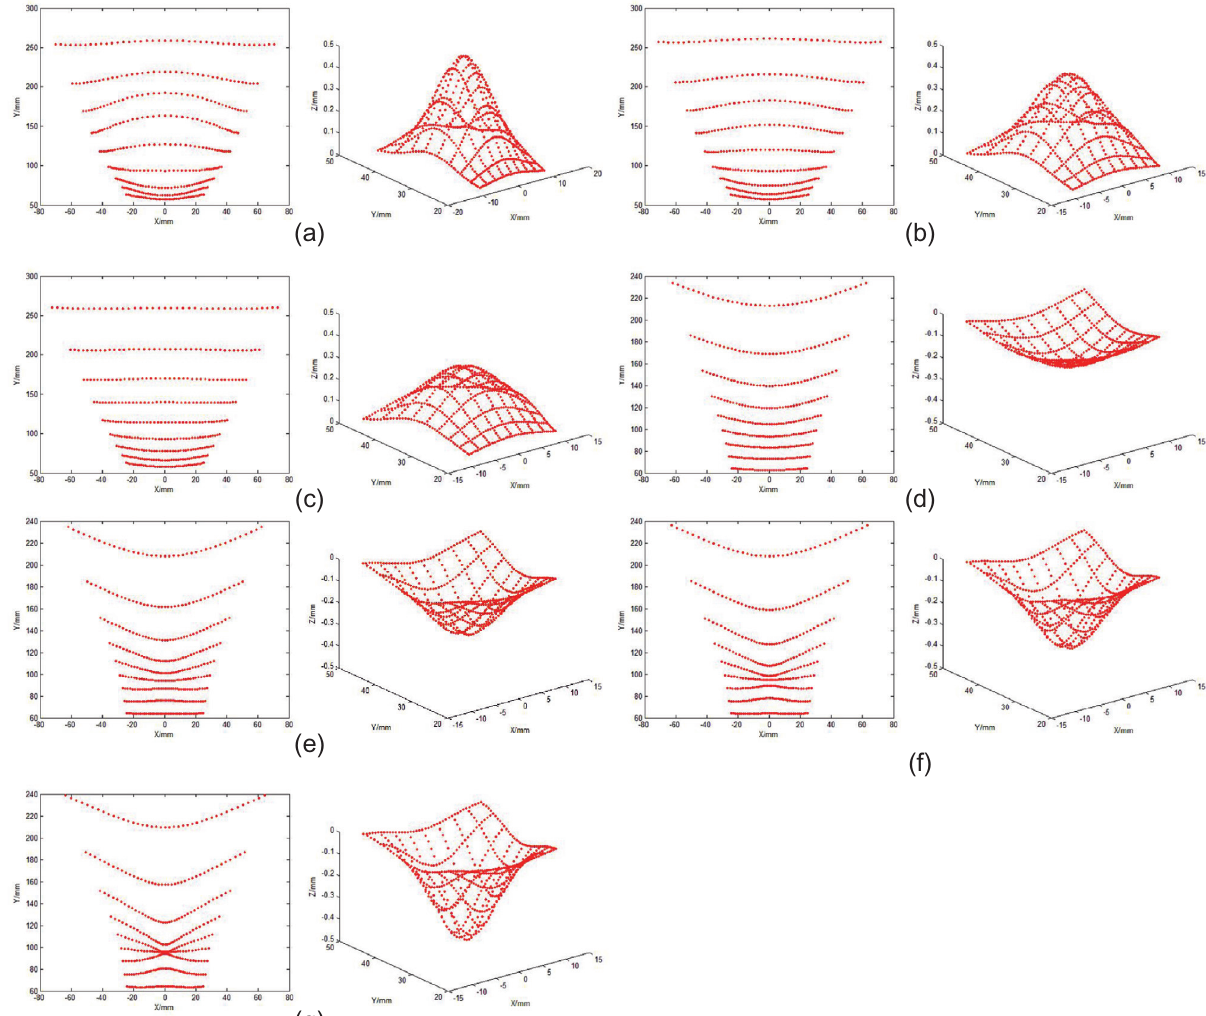
Figure 8: The dynamic development of weld pool surface. (a) r = 5.8. (b) r = 6.4. (c) r = 7.6. (d) r = 8.8. (e) r = 7. (f) r = 6.2. (g) r =